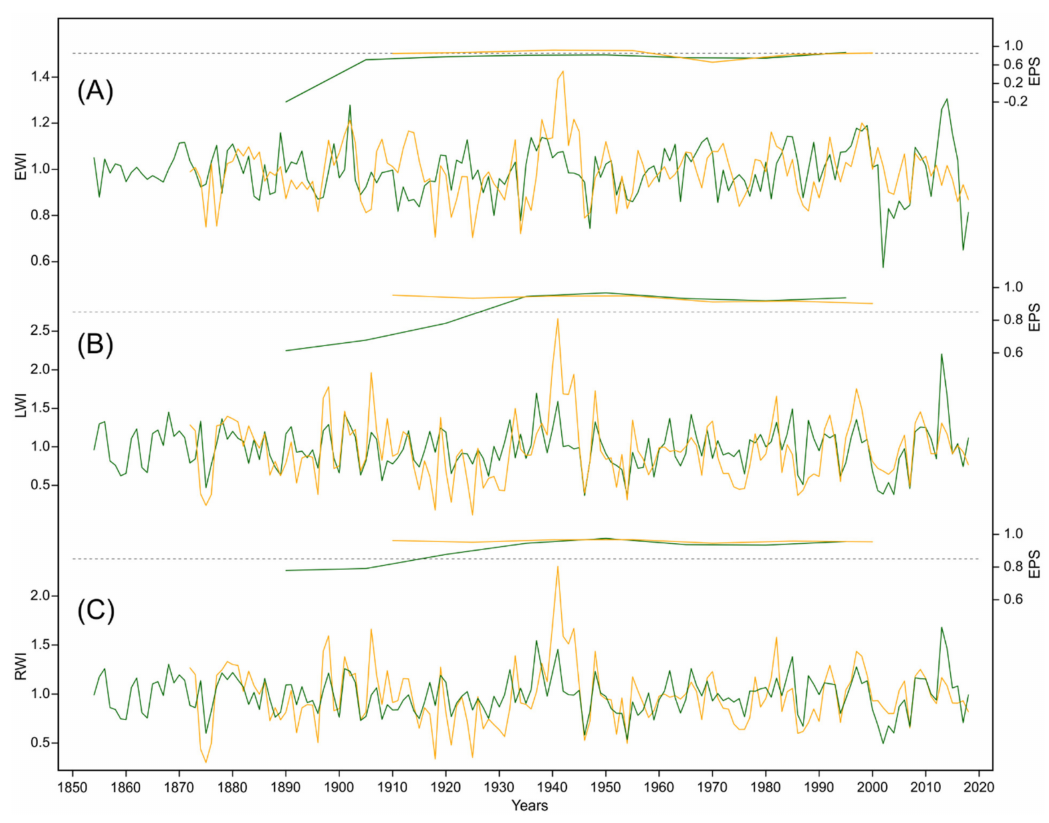
Figure 3. Tree ring index chronologies for ash—orange, and oak—dark green; ( A ) earlywood (EW), ( B ) latewood (LW), ( C ) tree ring-widths